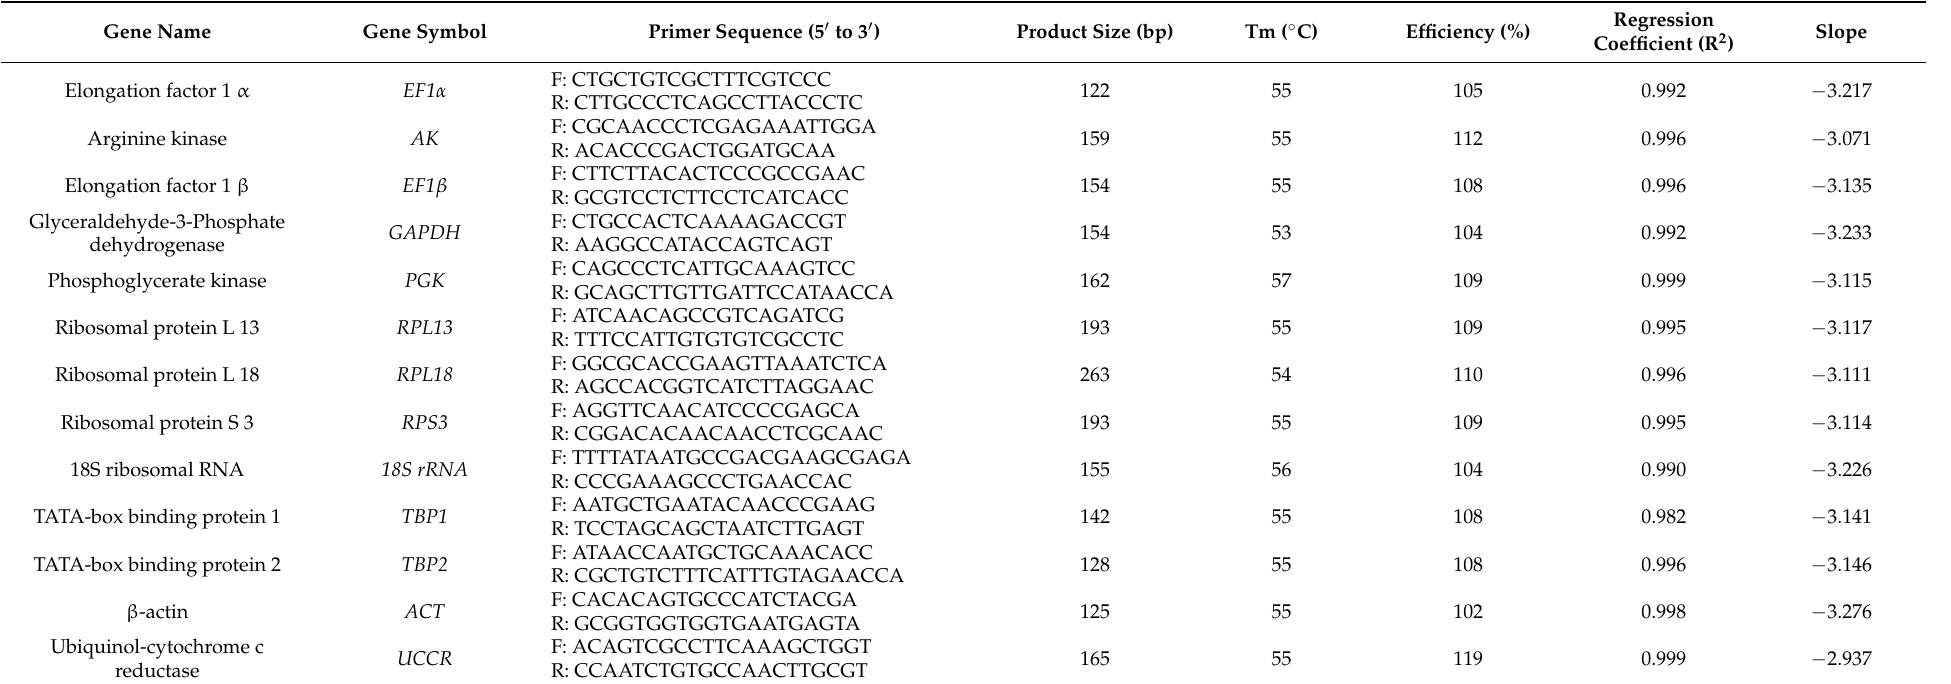
Table 1. Primer sequences and amplicon characteristics of the thirteen reference genes in Cnaphalocrocis medinalis